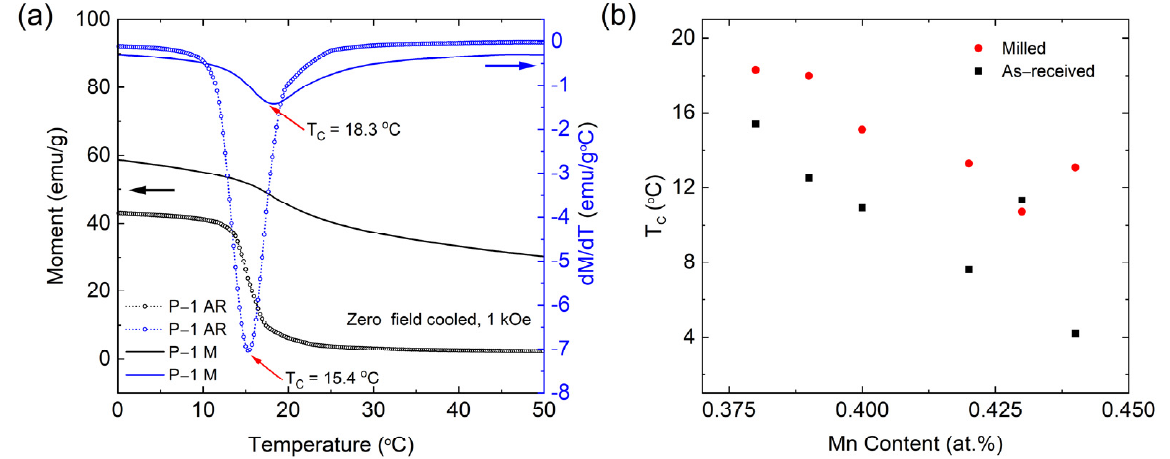
Figure 5. Magnetization of the milled powders, measured in 1 kOe after cooling in zero field. M ( T ) and d M /d T for the sample with Mn content of 0.38 at.% is shown in ( a ), demonstrating the broad transition at T c . The peak Curie temperatures of 15.4 °C and 18.3 °C for the as-received and milled powders, respectively, are marked by red arrows. The T c for all alloys (0.38, 0.39, 0.40, 0.42, 0.43, and 0.44 at.% Mn) is presented in ( b ), indicating a general downward trend of T c with increasing Mn content but a persistent increase in T c due to milling.